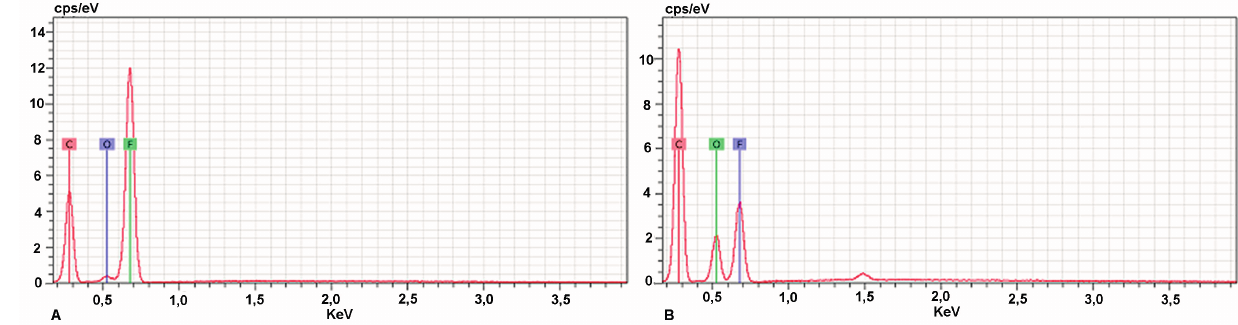
Figure 2. EDX spectra of PVDF membrane ( A ) and MIM ( B ).